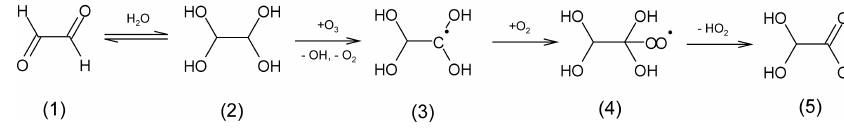
Scheme 2. Reaction mechanism for fully hydrated glyoxal reacting with ozone.